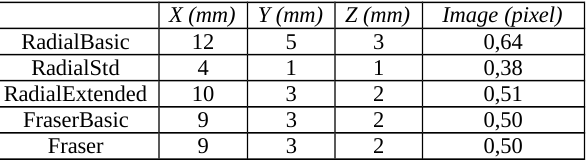
Table 2: MAE on the GCP during the calibration process